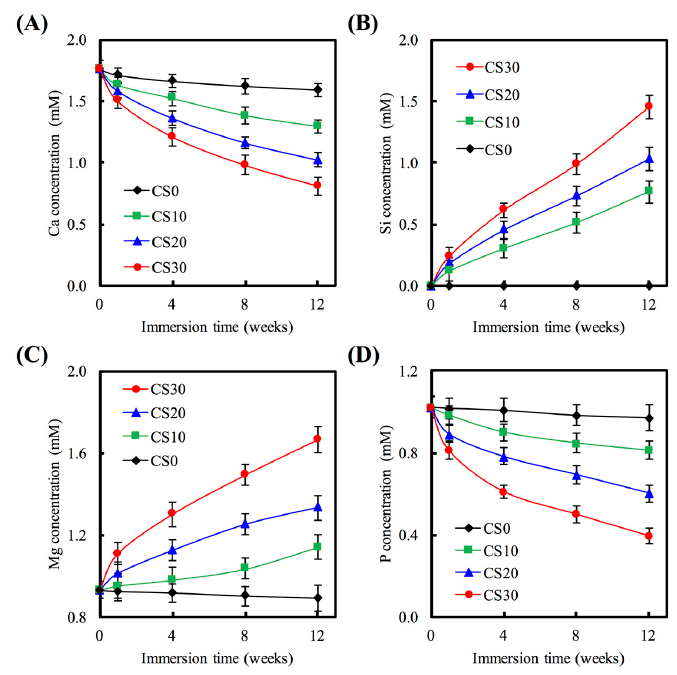
Figure 5. ( A ) Ca; ( B ) Si; ( C ) Mg; and ( D ) P concentration of SBF after immersion for different time.